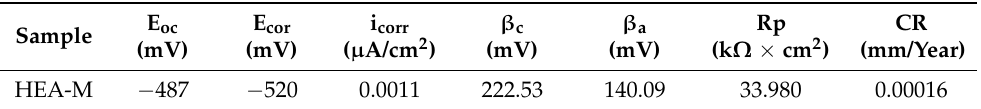
Table 2. CoCrFeNiMo 0.85 alloy parameters for electrochemical testing in chloride-containing solution